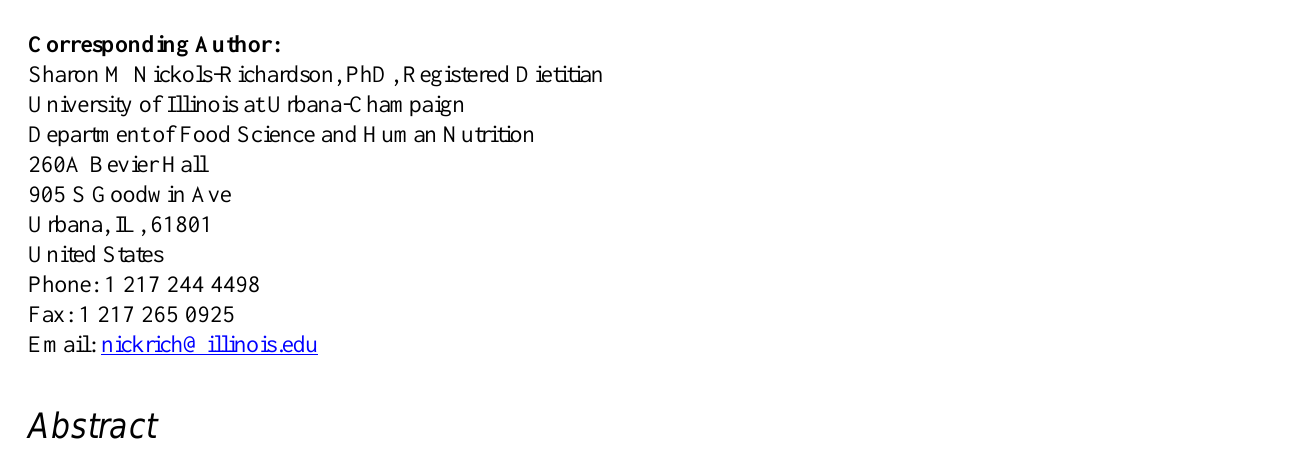
body weight; weight gain prevention; weight maintenance;